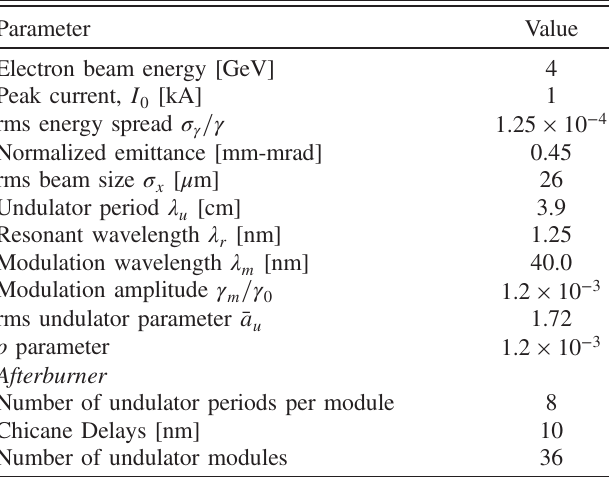
TABLE I. Simulation